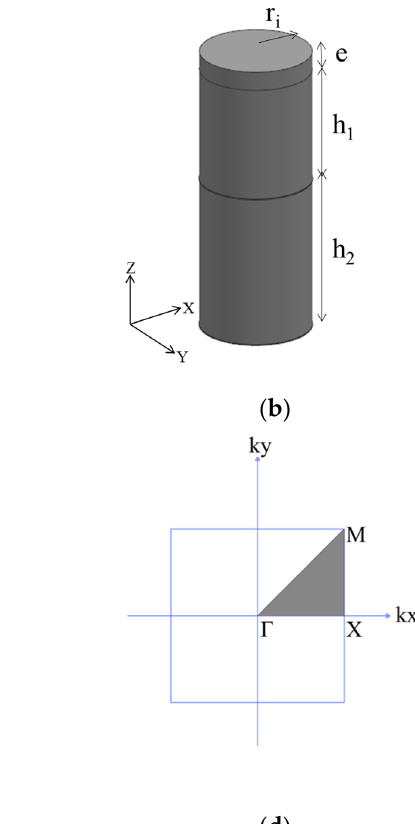
Table 1. Physical properties of silicone rubber, lead, and aluminum [17,23].